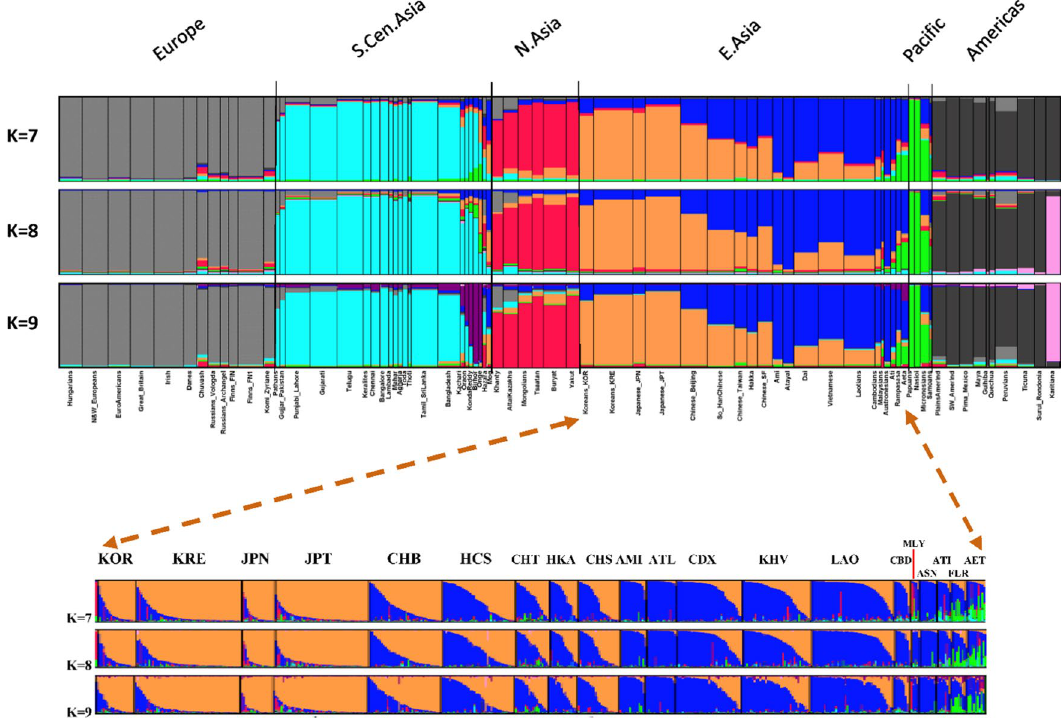
Figure 4. STRU CTU RE results by population averages for 74 populations at K = 7 through K = 9. At each K value the result with the highest likelihood is shown as population average. This subset of the 122 populations is in the same order as in Table 2. The plots of individuals for these three K values are shown in Supplemental Fig. S4; plots of likelihoods for K values are in Supplemental Fig. S6. In the lower part of the figure, individual bar plots are shown for East Asia with the individuals sorted by the major cluster values within each